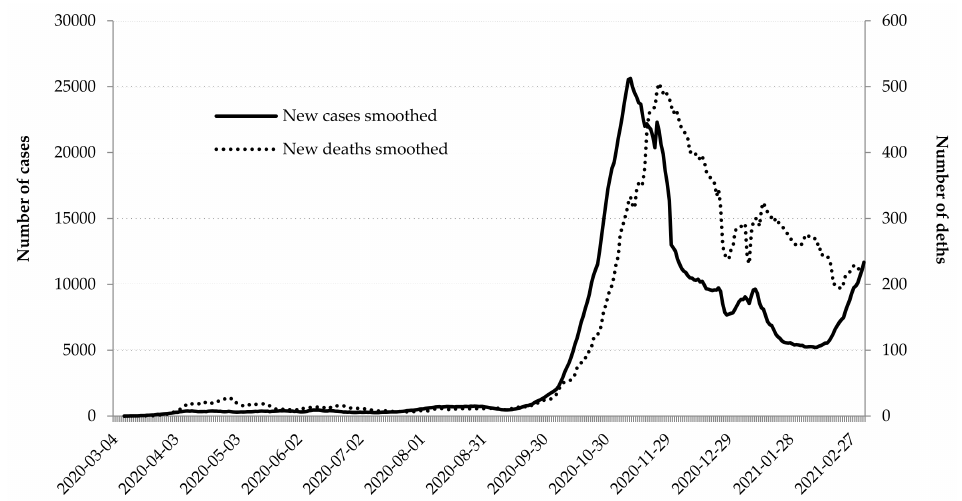
Figure 1. The magnitude of incidence and death due to COVID-19 in Poland between 4 March 2020 and 4 March 2021. Source: Own study based on Our Word in Data [95].